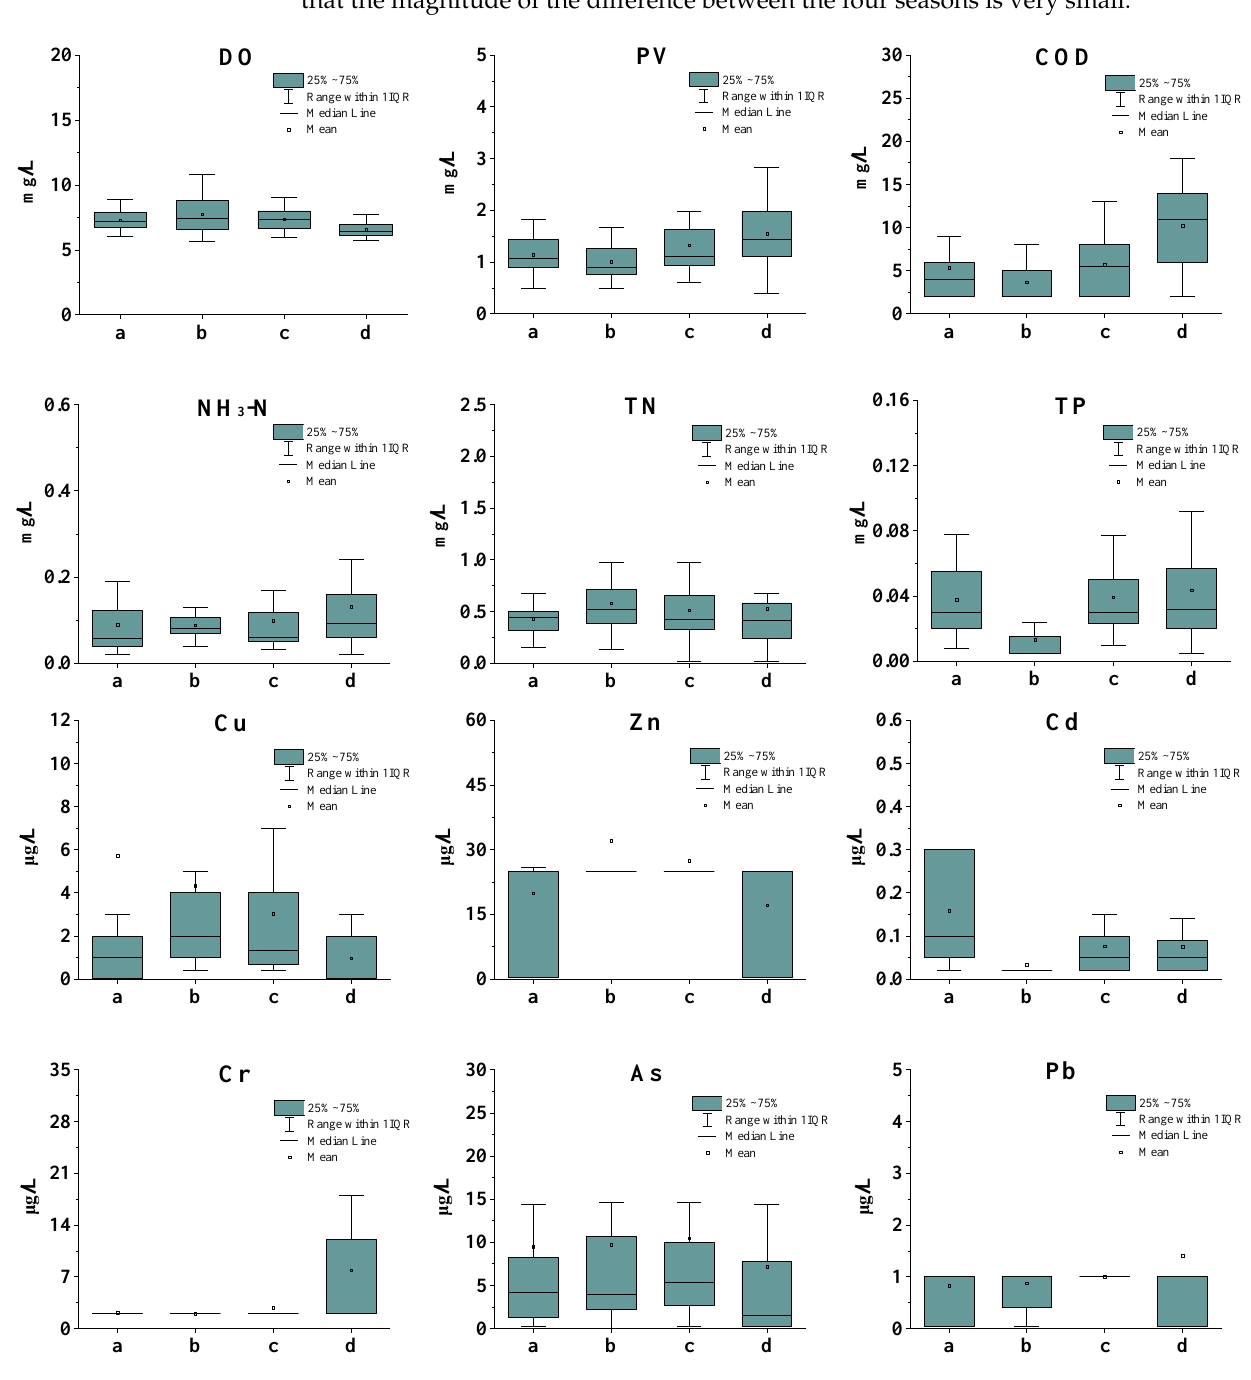
Figure 2. Heavy metal box diagram (a—spring; b—summer; c—autumn; d—winter).